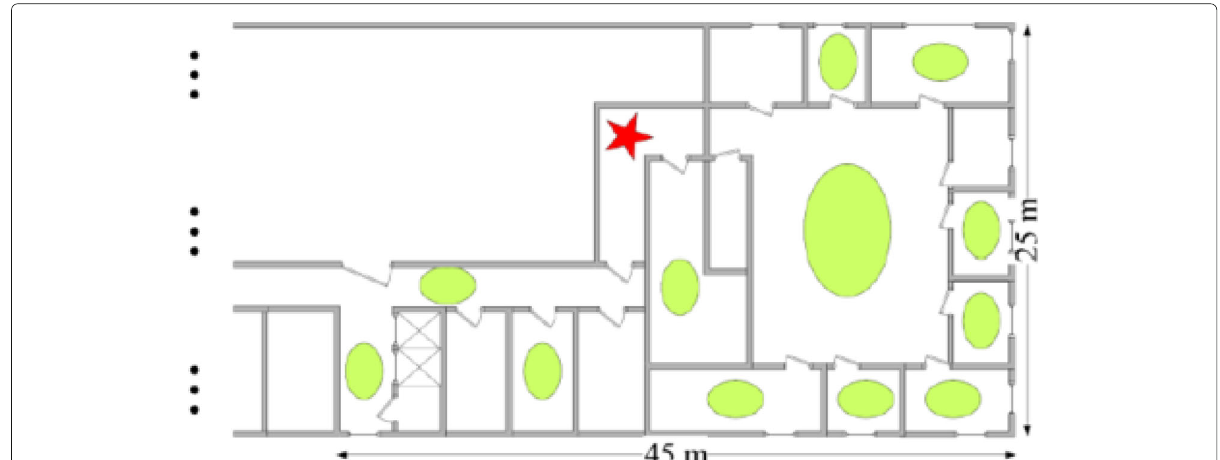
Fig. 10 Floor plan of the indoor testing